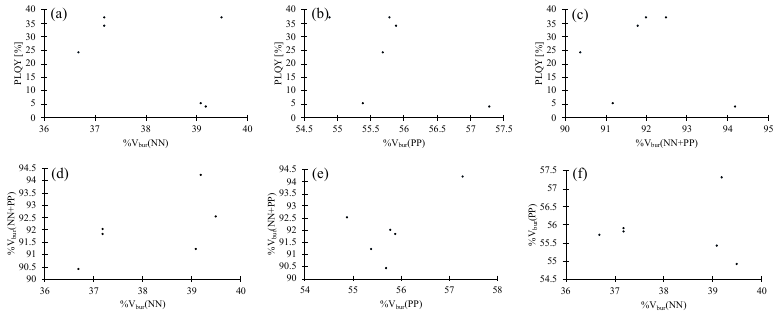
Figure 10. Scatter plots of PLQY, %V bur (NN), %V bur (PP) and %V bur (NN + PP) for compounds 13 – 18 [18]. ( a ) Scatter plot of PLQY vs. %V bur (NN). ( b ) Scatter plot of PLQY vs. %V bur (PP). ( c ) Scatter plot of PLQY vs. %V bur (NN + PP). ( d ) Scatter plot of %V bur (NN) vs. %V bur (NN + PP). ( e ) Scatter plot of %V bur (PP) vs. %V bur (NN + PP). ( f ) Scatter plot of %V bur (NN) vs. %V bur (PP).